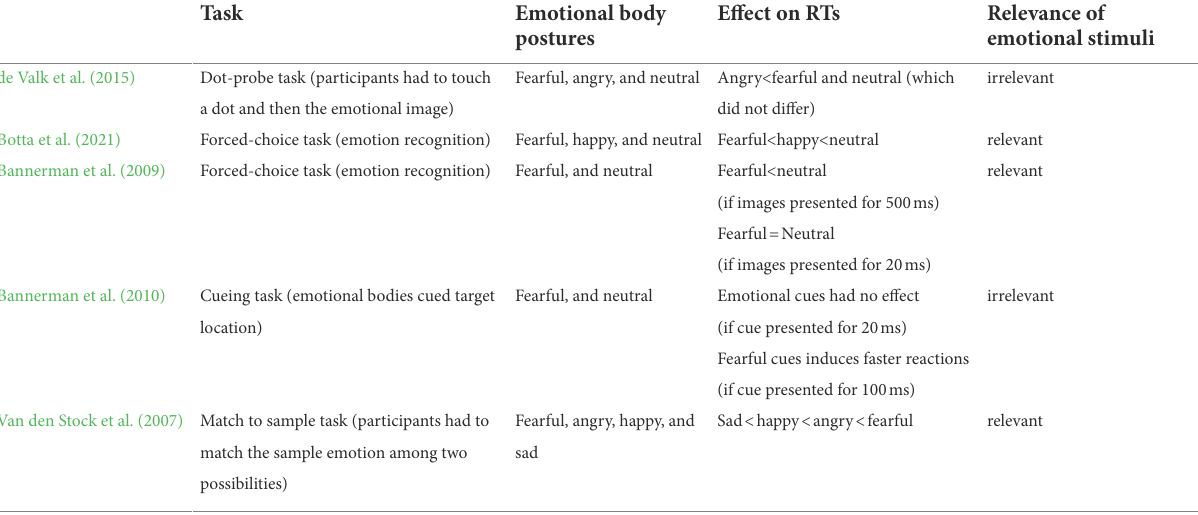
TABLE 2 Effect on manual reaction times (RTs) to the presentation of emotional body images (see text for more